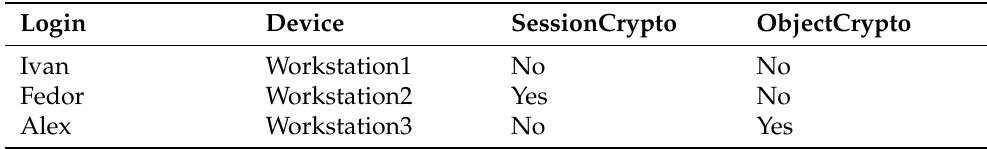
Table 13. Example of query results of the algorithm for Feature